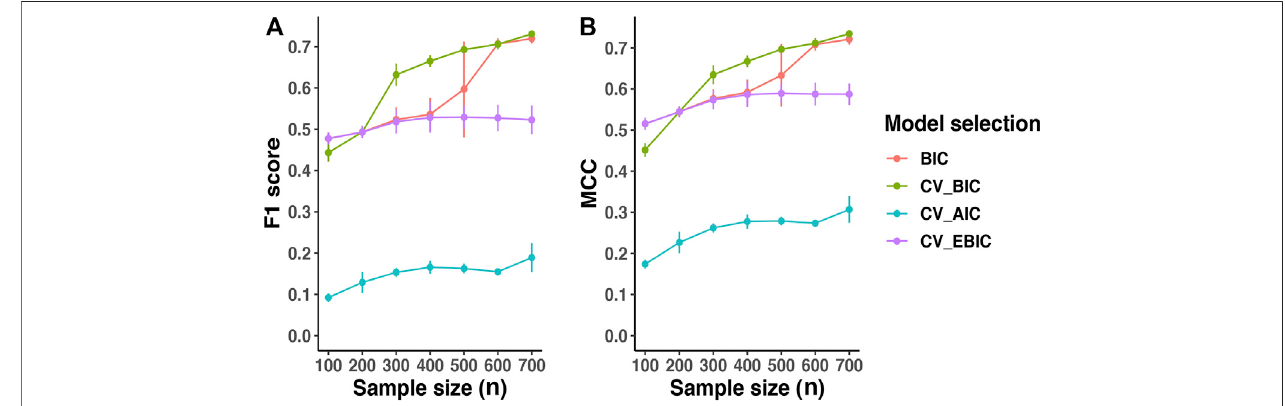
FIGURE 2 | Comparison of Model Selection Criteria. The simulated protein network included 500 ( p ) nodes. The overlapping between prior information and target true network is 50 % . With the same true network and its corresponding covariance matrix ( Σ true ), we created various sizes ( n ) of multiple normal expression datafortesting.The λ wasoptimizedwithregularBIC,cross-validation-basedBIC(CV_BIC),cross-validation-basedAIC(CV_AIC)andcross-validation-basedEBIC (CV_EBIC). The AhGlasso algorithm with the optimal λ s derived from different criteria outputs the predicted network. The F1 score and MCC were calculated based on the estimated network and true network. For each simulation setting, the simulations were repeated 5 times. The lines represent the mean scores for the simulated sample size and the error bars represent the standard error of the mean. Of note, similar results were achieved in various p and n simulations (data not